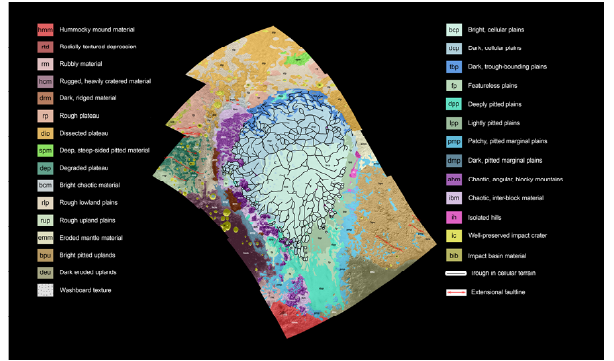
Figure 3. This geological map covers a portion of Pluto’s surface that measures 2,070 kilometers from top to bottom, and includes the vast nitrogen-ice plain informally named Sputnik Planum and surrounding terrain. The key explains the colors that represent different geological terrains. Each terrain, or unit, is defined by its texture and morphology – smooth, pitted, craggy, hummocky or ridged, for example. How well a unit can be defined depends on the resolution of the images that cover it. All of the terrain in this map has been imaged at a resolution of approximately 320 meters per pixel or better, meaning scientists can map units with relative confidence. The various blue and greenish units that fill the center of the map represent different textures seen across Sputnik Planum, from the cellular terrain in the center and north, to the smooth and pitted plains in the south. The black lines represent the troughs that mark the boundaries of cellular regions in the nitrogen ice. The purple unit represents the chaotic, blocky mountain ranges that line Sputnik’s western border, and the pink unit represents the scattered, floating hills at its eastern edge. The possible cryovolcanic feature informally named Wright Mons is mapped in red in the southern corner of the map. The rugged highlands of the informally named Cthulhu Regio is mapped in dark brown along the western edge, and is pockmarked by many large impact craters, mapped in yellow. The base map for this geologic map is a mosaic of 12 images obtained by the Long Range Reconnaissance Imager (LORRI) at a resolution of 390 meters per pixel (White et al.,